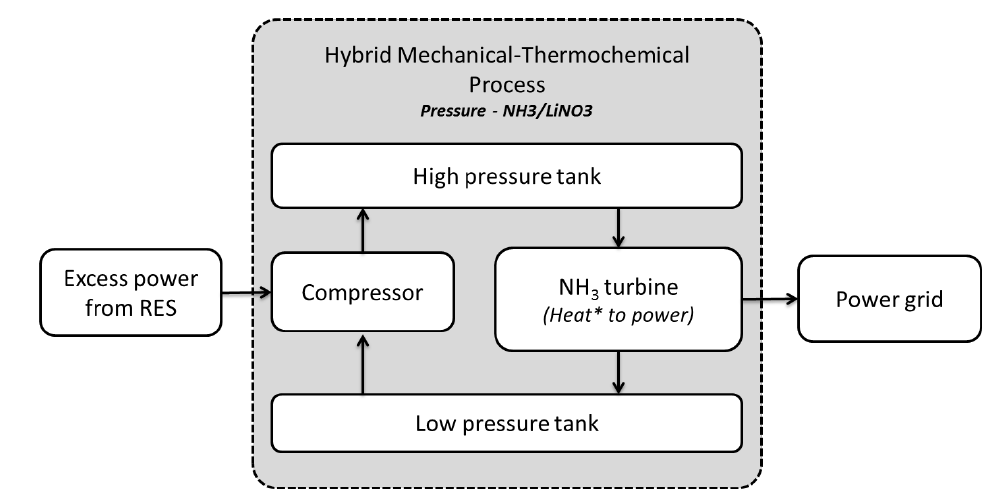
Figure 11. PtH/TCTES system developed by Rodriguez et al. [323]. *Heat is exchanged between the Figure 11. PtH / TCTES system developed by Rodriguez et al. [318]. * Heat is exchanged between the two tanks in order to compensate the ammonia expansion/compression cycle. two tanks in order to compensate the ammonia expansion / compression cycle. Table 4. Thermochemical storage in PtH and PtH / HtP